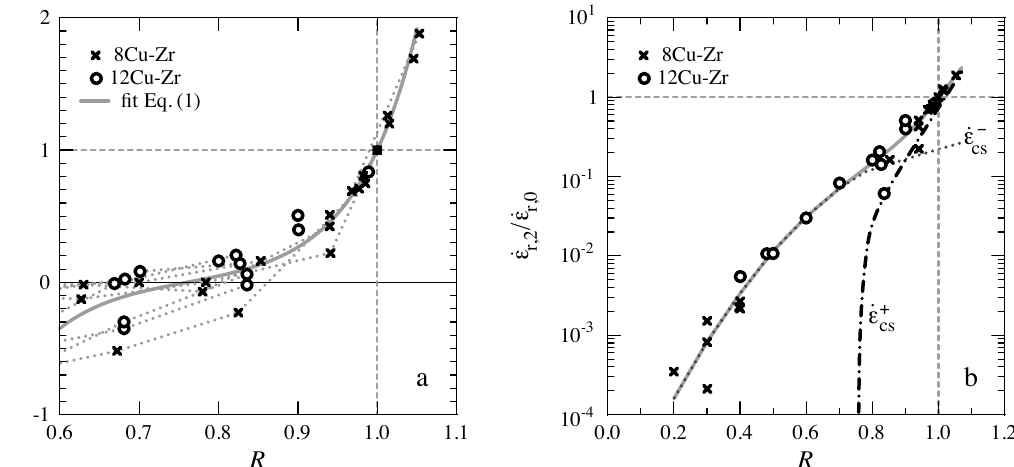
Figure 6. Normalized constant structure strain rate ˙ (cid:101) r after qs deformation of 8/12Cu–Zr at σ r,0 ≈ 275MPa as function of relative creep load R : ( a ) ˙ (cid:101) r,1 , grey dotted lines connect data from same test with stepwise load reduction, ( b ) ˙ (cid:101) r,2 (symbols connected by solid grey line); on log scale with estimates of ˙ (cid:101) − cs (dotted black) and ˙ (cid:101) + cs (dash-dotted black); see